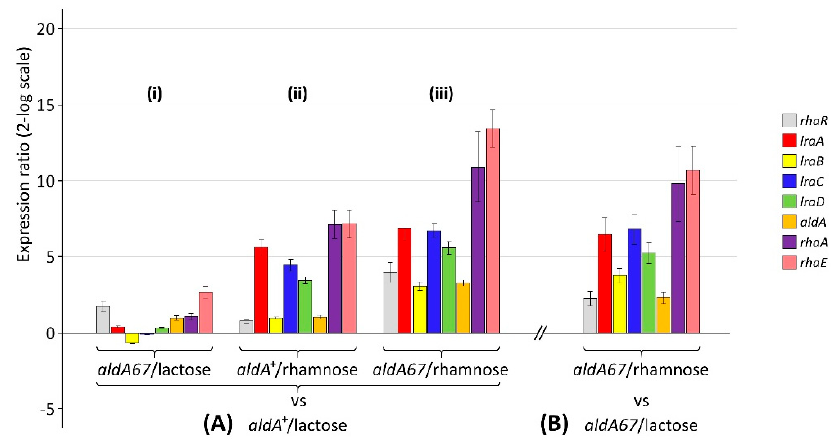
Figure 2. Effect of the aldA67 allele on the expression of genes involved in L-rhamnose utilisation under inducing and non-inducing conditions: ( A ) relative transcript abundance of aldA + and aldA67 mycelia under inducing and non-inducing conditions vs. the wild-type strain in non-inducing medium (panels ( i – iii ) are described in the text); ( B ) relative transcript abundance of aldA67 mycelia under inducing conditions vs. the aldA67 strain in non-inducing medium.